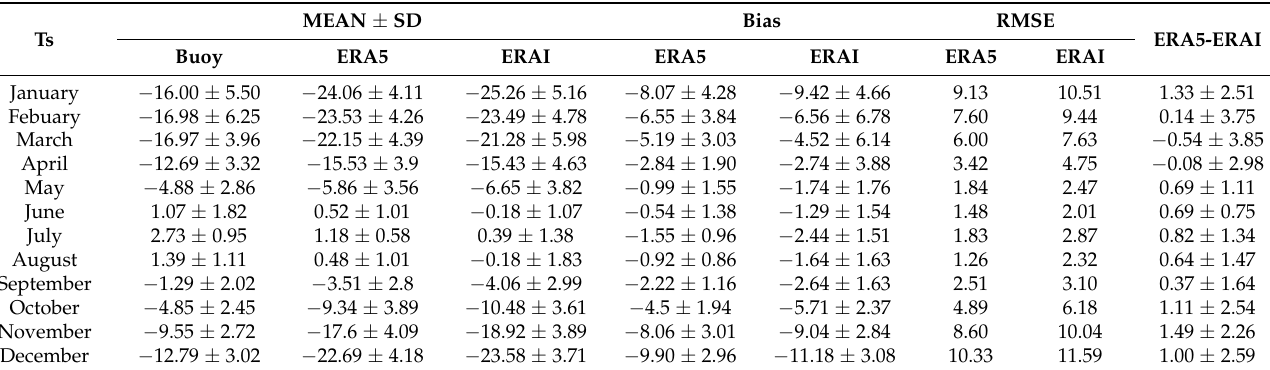
Table 5. Monthly statistics of the mean, bias, and RMSE for Ts (°C).